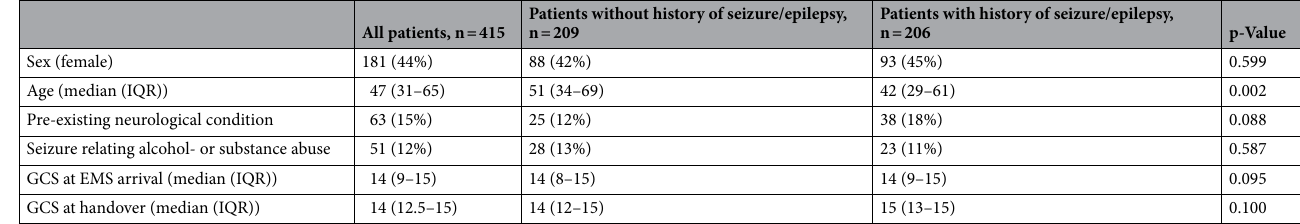
Table 1. Characteristics of all patients stratified by known and unknown diagnosis of epilepsy. “Pre-existing neurological condition” includes brain tumor and metastases, intracranial hemorrhage and malformations as well as infantile brain damage and stroke. GCS Glasgow-Coma-Scale, EMS Emergency Medical Service, n/a not available.